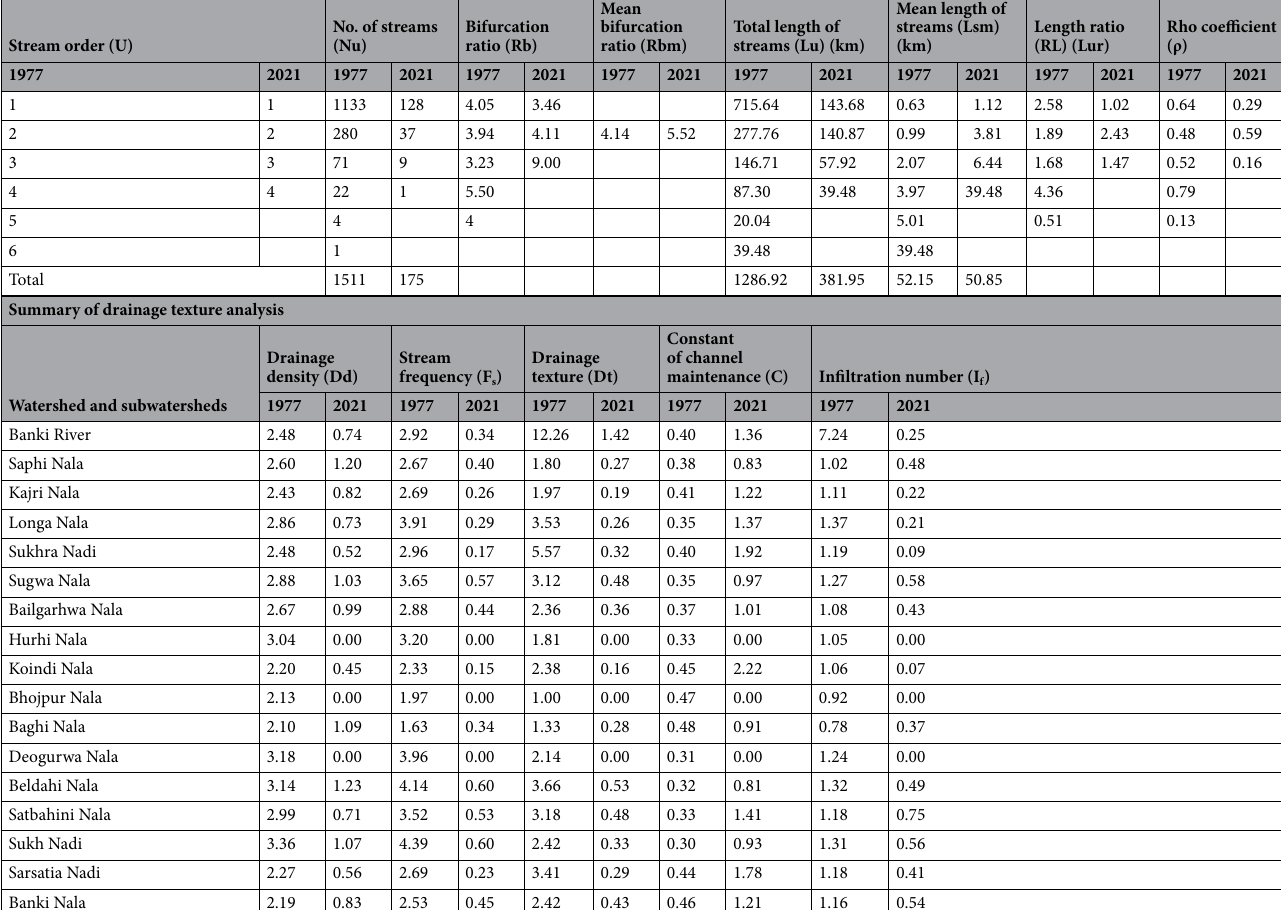
Table 2. Summary of linear aspects and drainage texture analysis of Banki watershed and subwatersheds.